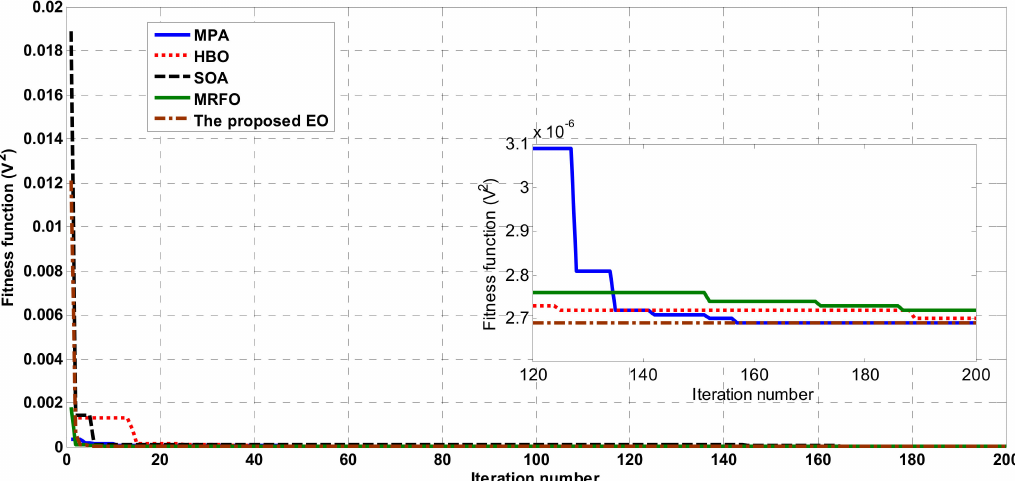
Figure 5. The variation of fitness function during iterative process for all employed optimizers applied for steady-state SOFC model.